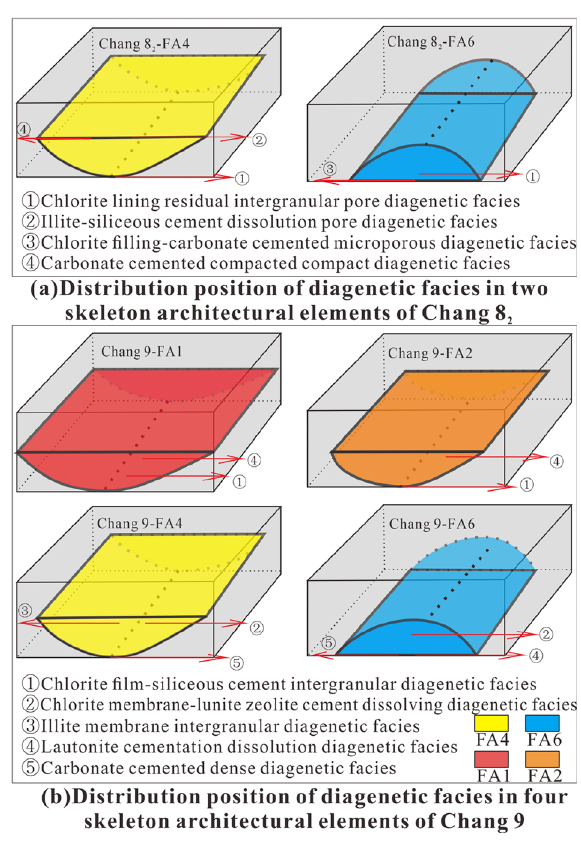
Figure 18. Distribution of diagenetic facies within the architectural